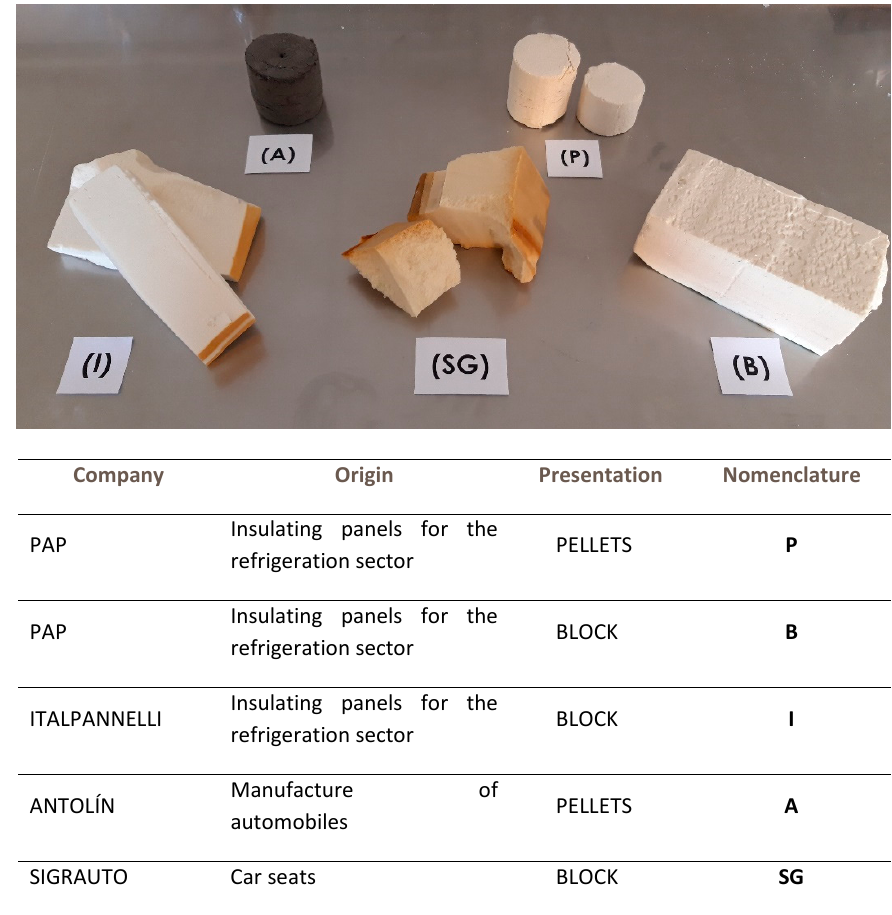
Figure 1. Polyurethane foams from different industries.